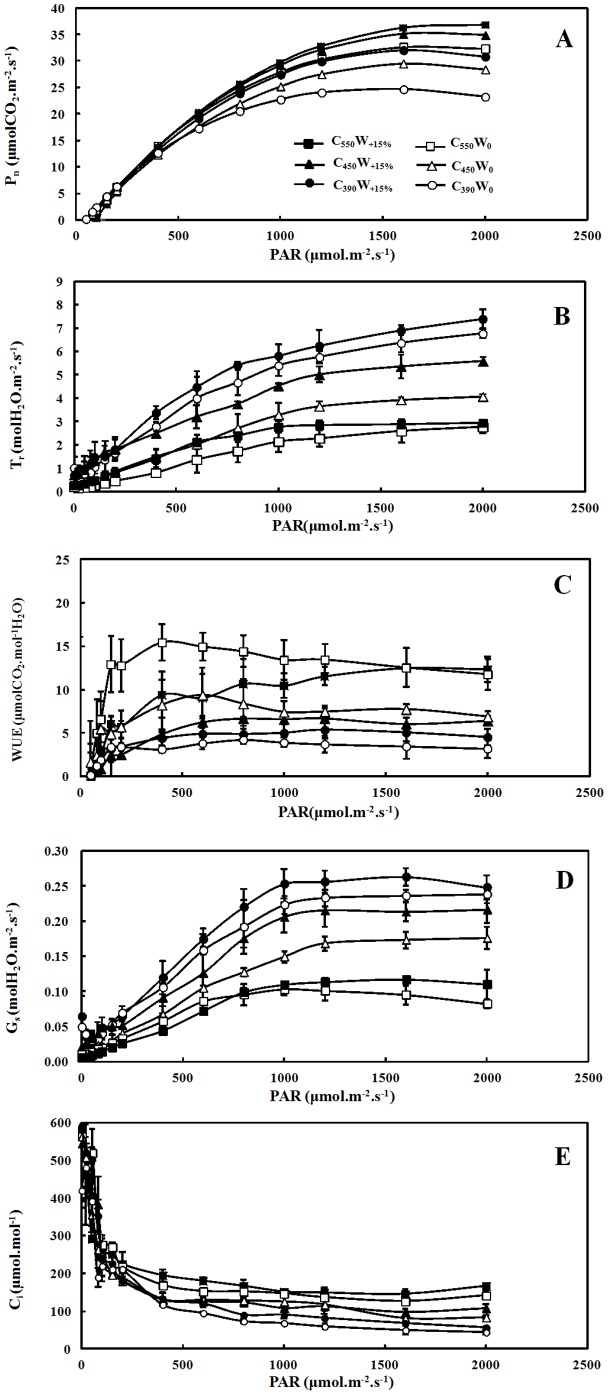
Dynamic curves of (A) net photosynthetic rate (P
n), (B) transpiration rate (T
r), (C) water use efficiency (WUE), (D) stomatal conductance (G
s) and (E) intercellular CO2 concentration (C
i) (means ± SD) (n = 3) in six treatments (C550W+15%, C550W0, C450W+15%, C450W0, C390W+15% and C390W0) in silking stage of maize under effects of elevated [CO2] and irrigation.